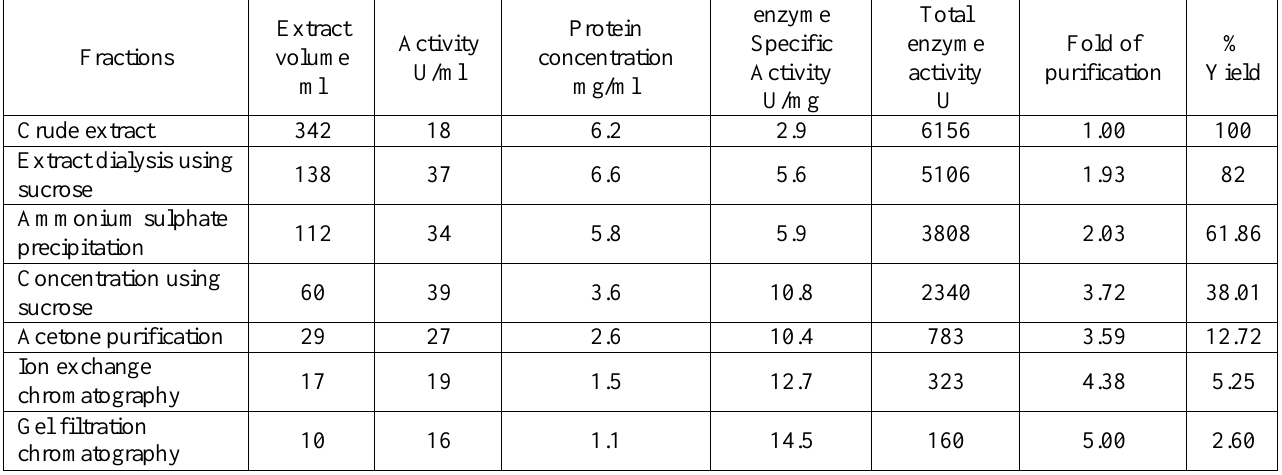
Figure 1: Pullulanase precipitation using Ammonium sulphate. Table 1: Purification of pullulanase from300 g of edible mushroom A.